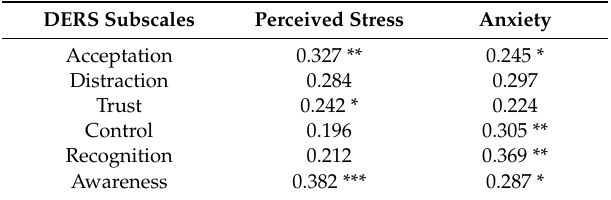
Table 7. Correlations between DERS subscales, perceived stress and anxiety